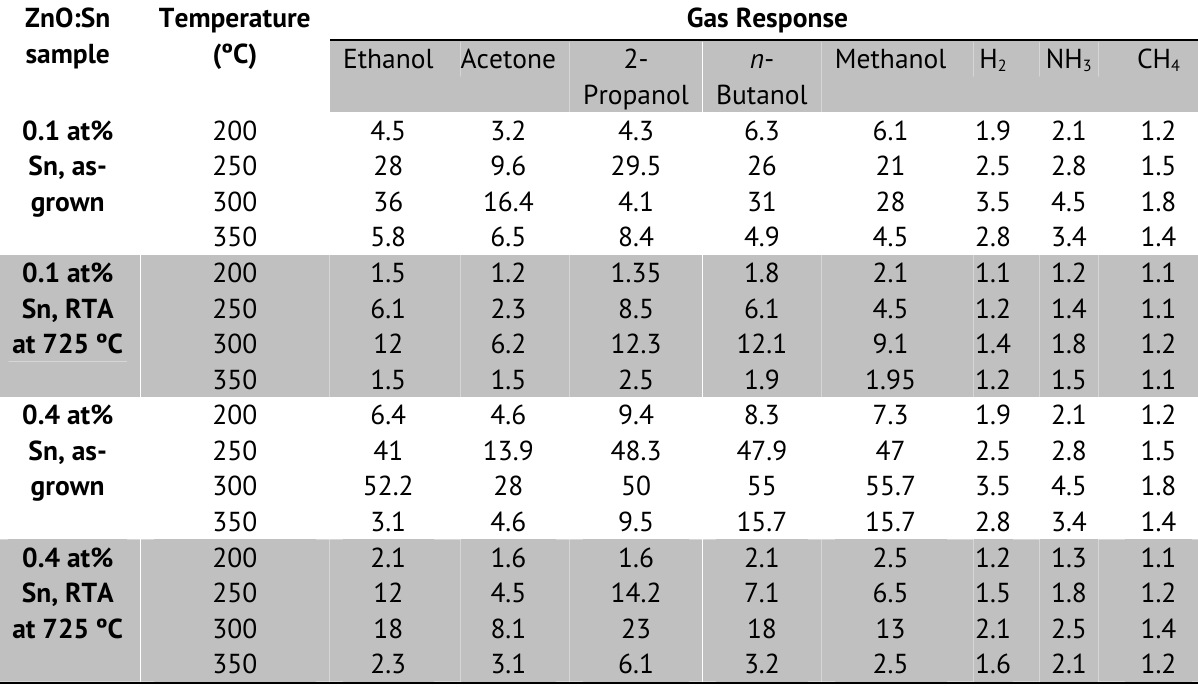
The gas response of ZnO:Sn samples to 100 ppm of VOCs vapors and 1000 ppm of H